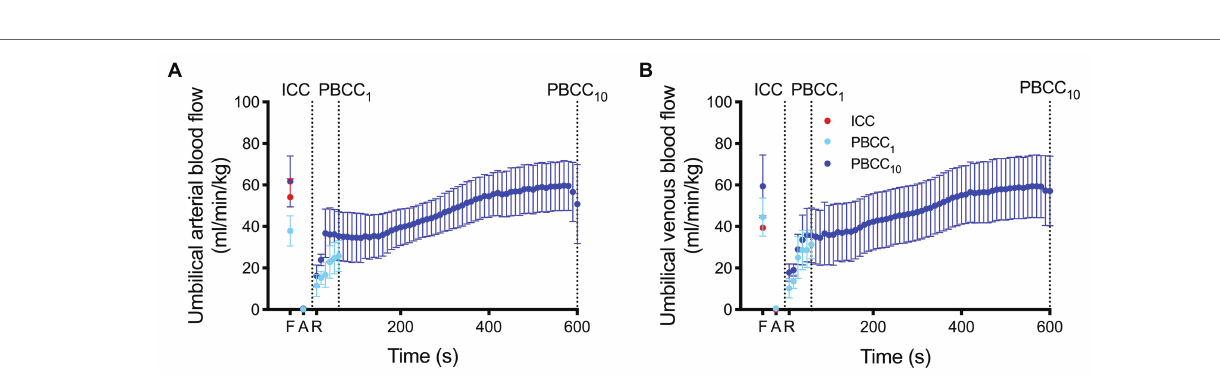
FIGURE 3 | (A) Umbilical arterial blood flow (UaBF) and (B) umbilical venous blood flow (UvBF) in ICC (red) and PBCC 10 lambs (dark blue) measured prior to asphyxia (fetal), at end asphyxia, and upon return of spontaneous circulation. Umbilical venous and arterial blood flow ceases in the ICC upon cord clamping. Data are mean ±